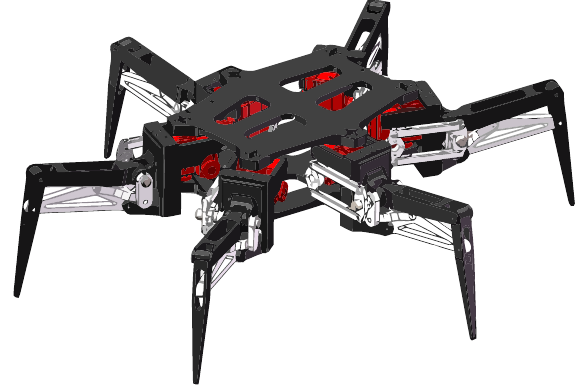
Figure 3. Three-dimenasional model of the robot.